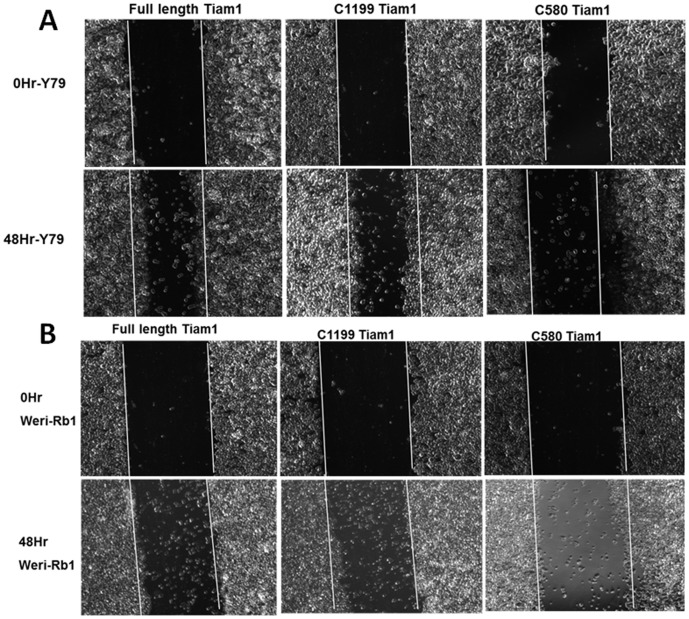
N-terminal PH domain maintains cell motility in retinoblastoma cells.Phase contrast images showing the migration of Y79 and Weri-Rb1 cells transfected with Full length Tiam1, C1199 Tiam1 and C580 Tiam1 in wound-healing assay. White line indicates the original wound edge which made by a pipette tip. The images were taken from 10 different locations. Cells transfected with full length and C1199 Tiam1 showing significant increase in cell migration rate compared to the cells transfected with C580 Tiam1. The Images were captured at 5× objective in AxioObserver microscope.